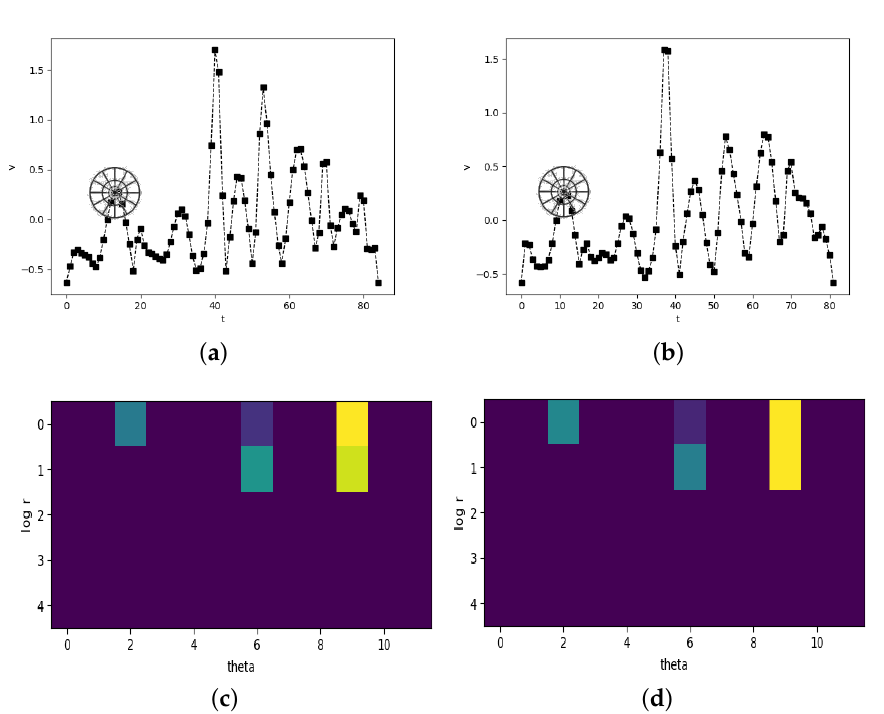
Figure 4. SC-DTW. ( a , b ) Time series of total velocity v from two signatures and a pair of corresponding points found by shape context. ( c , d ) show the shape context histograms of the points marked in ( a , b ),